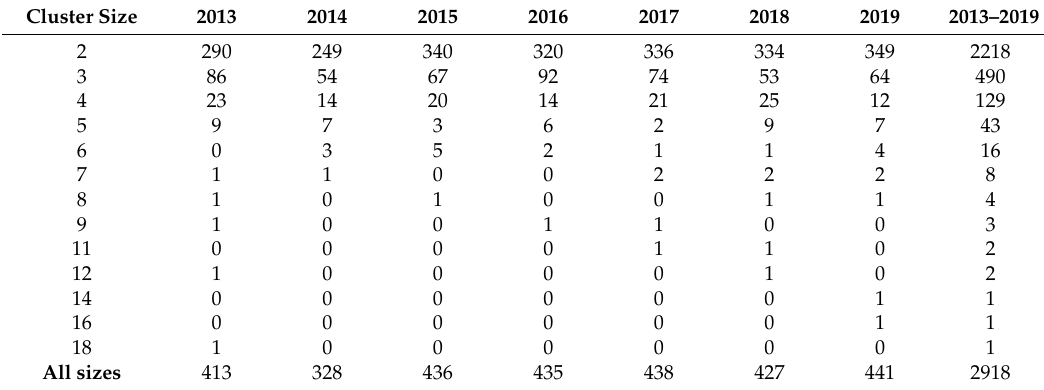
Table 2. TADS automatic outages in clusters by element type and voltage